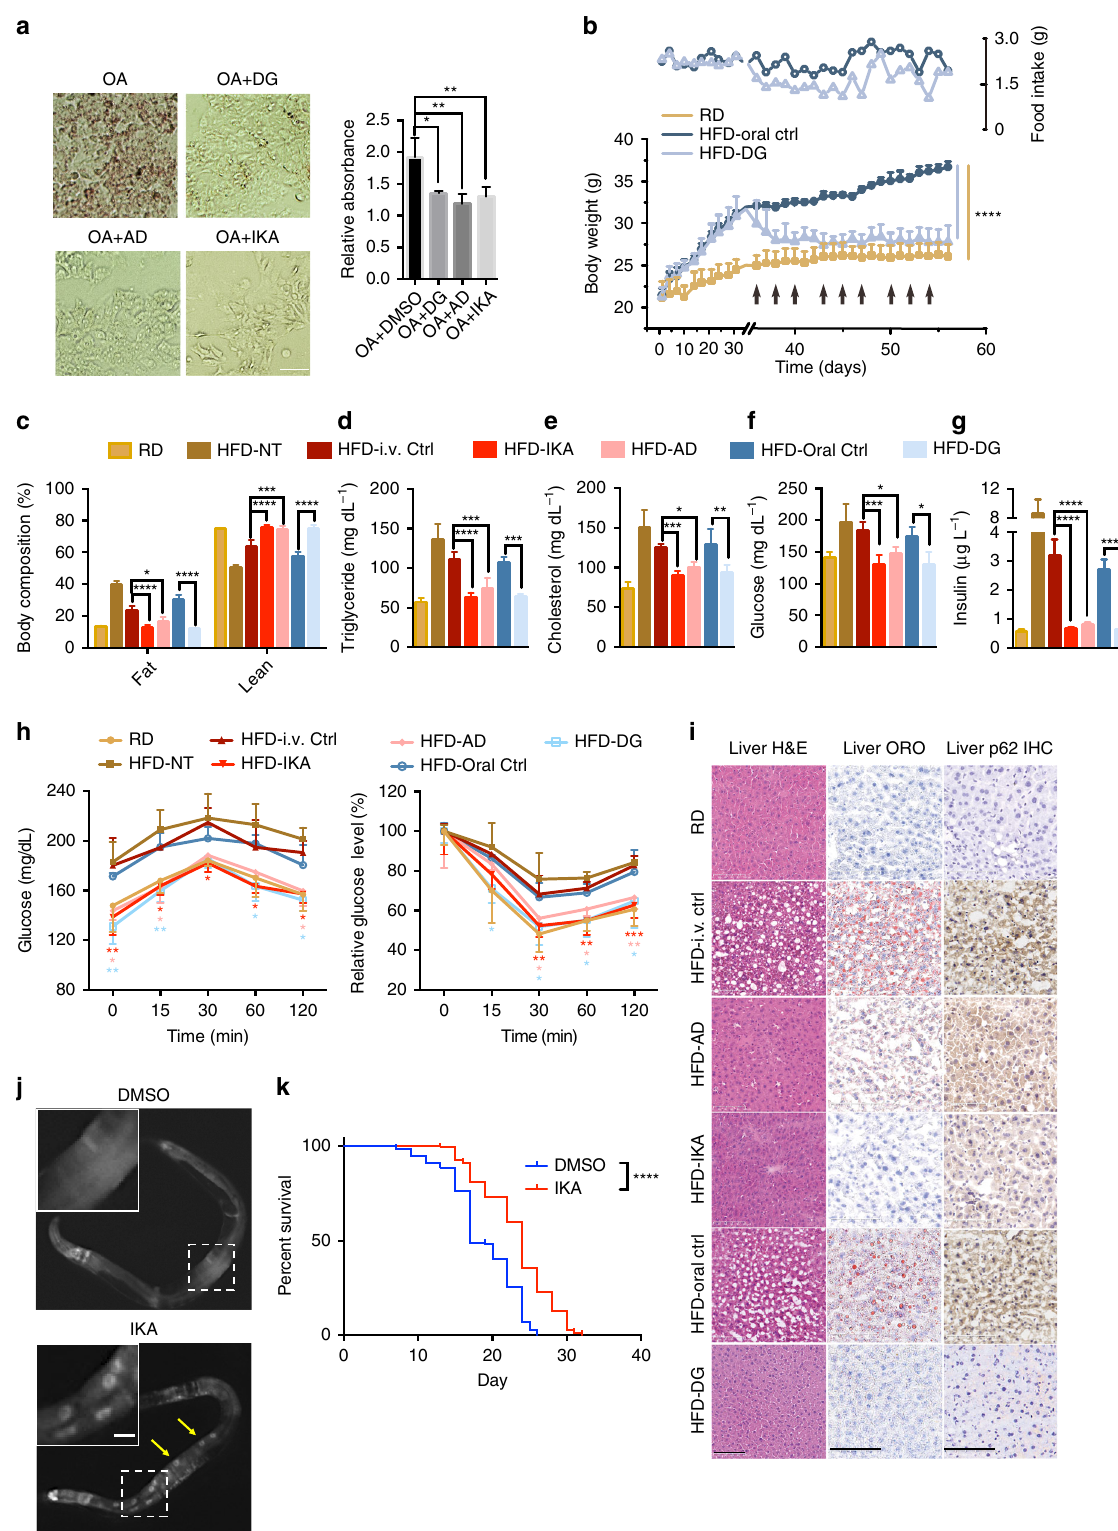
NATURE COMMUNICATIONS | 8: 2270 | DOI: 10.1038/s41467-017-02332-3 |